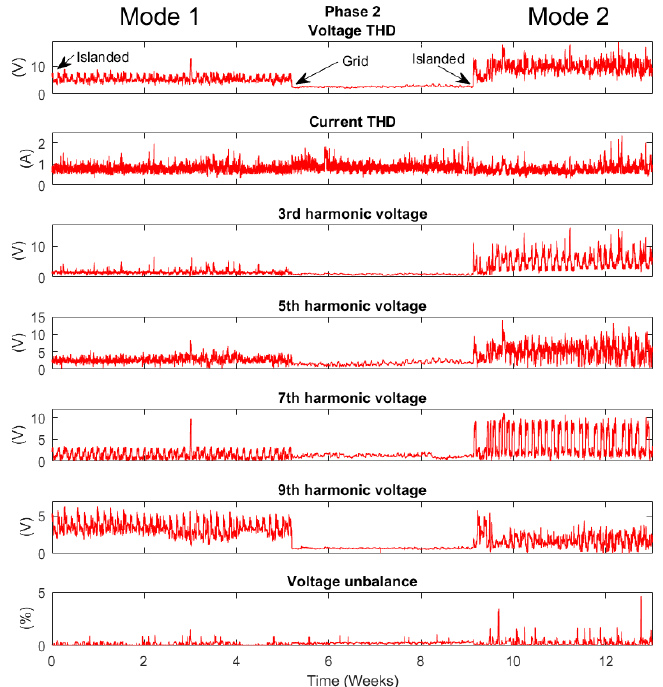
Figure 15. The voltage and current THD, 3rd, 5th, 7th, 9th harmonic voltage and voltage unbalance for phase 2 during a 13 week period in which the samples was extracted for a current rise larger than 4 A within 2 cycles. Energies 2018 , 11 , x FOR PEER REVIEW